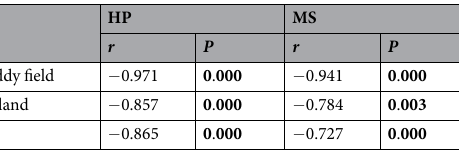
Table 3. Pearson correlation coefficients ( r ) between Q 10 values and POXC. HP and MS represent Huaping and Meishan, respectively (n =